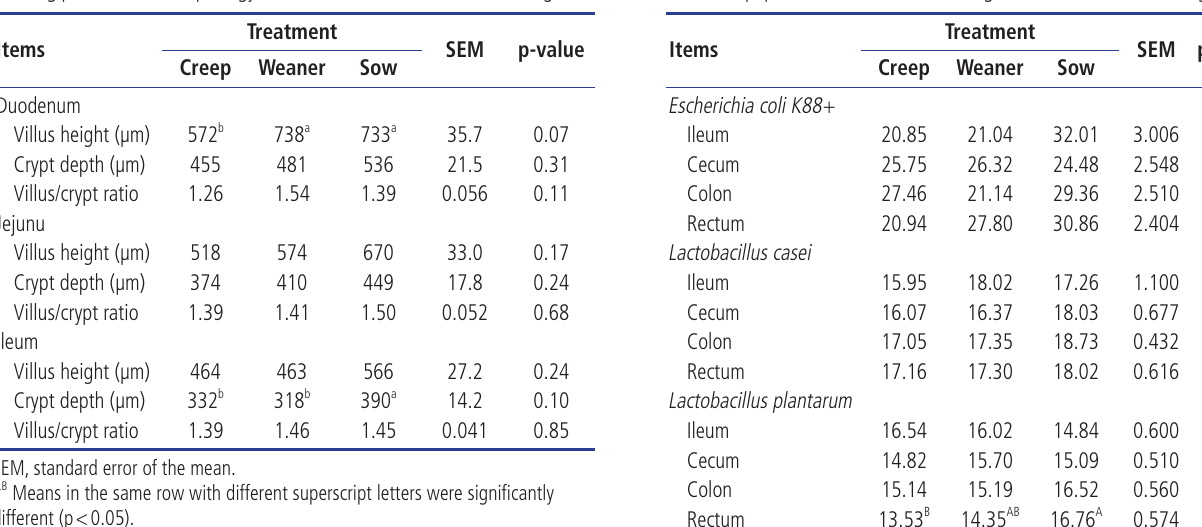
Table 6. Effect of different creep feed types during the lactating period on the microflora population 1) in the ileum and large intestine 4 d after weaning Treatment Items